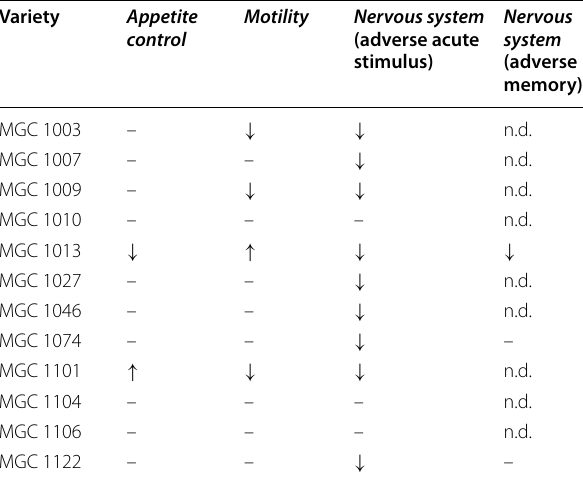
Table 1 Summary of the biological effects of polar